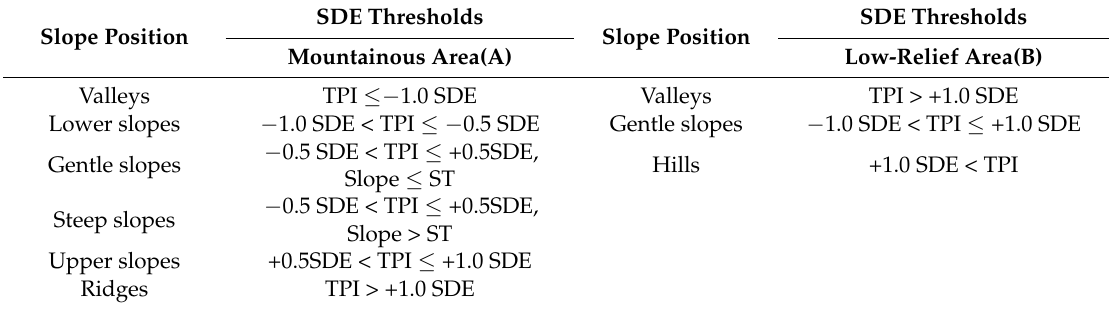
Table 2. Thresholds of standard deviation of elevation (SDE) corresponding to different slope positions. Slope